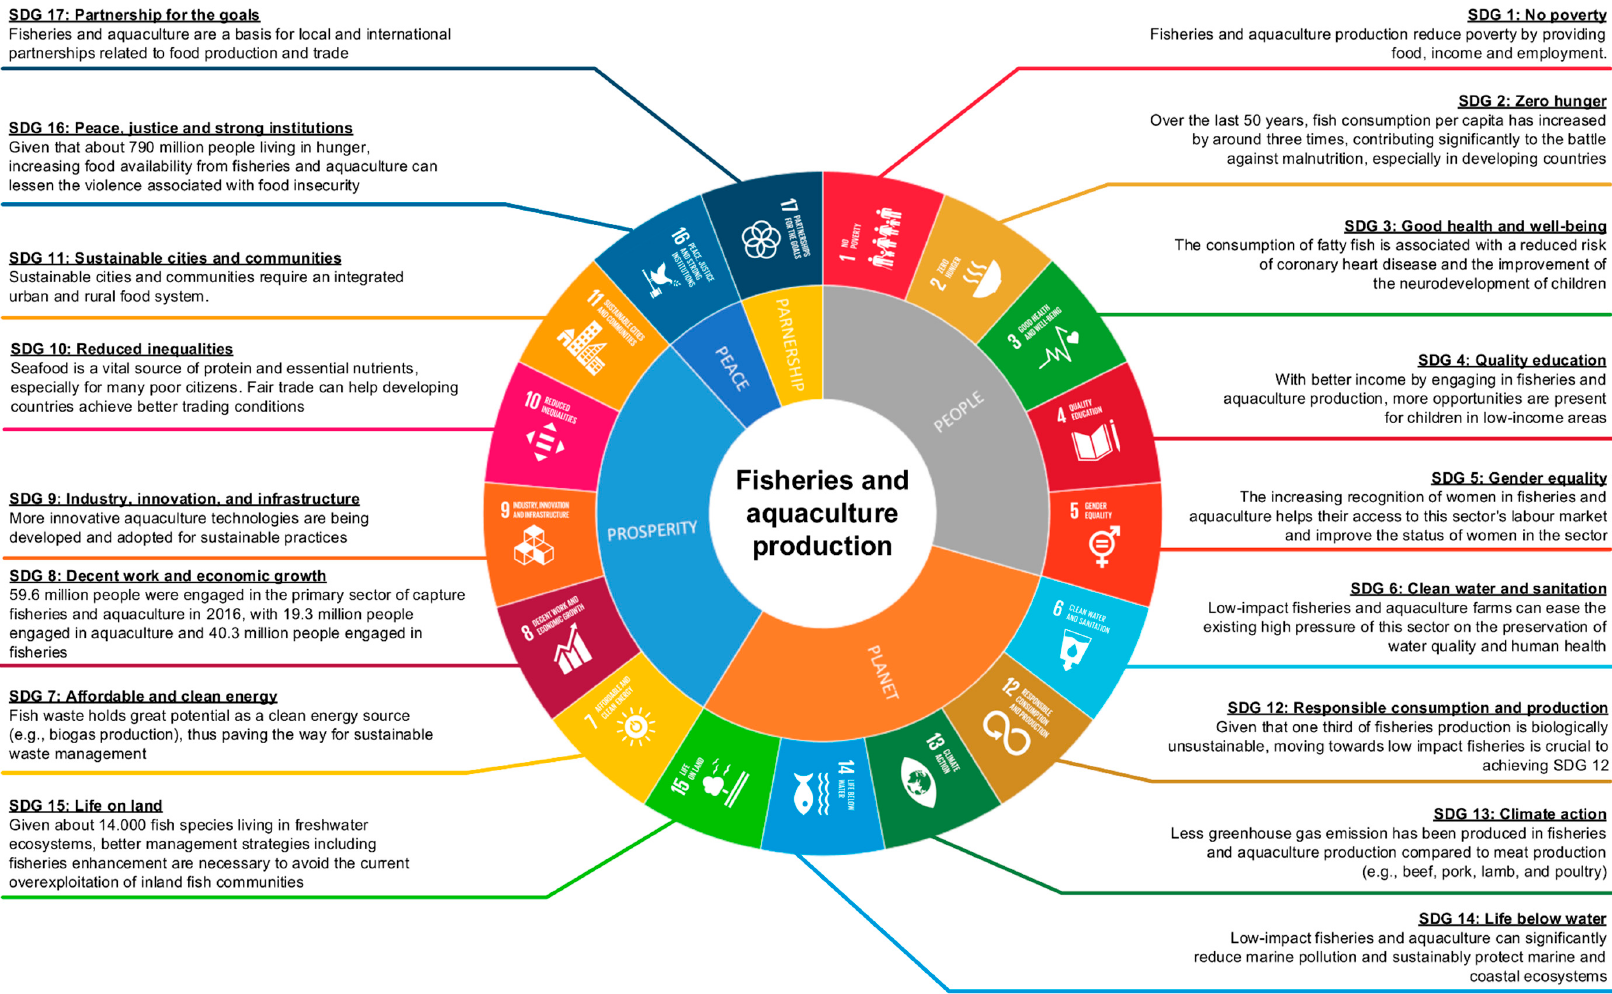
Figure 4. The contributions of capture fisheries and aquaculture production in underpinning the achievement of the Sustainable Development Goals (SDGs). Adapted from Ho and Goethals [46].